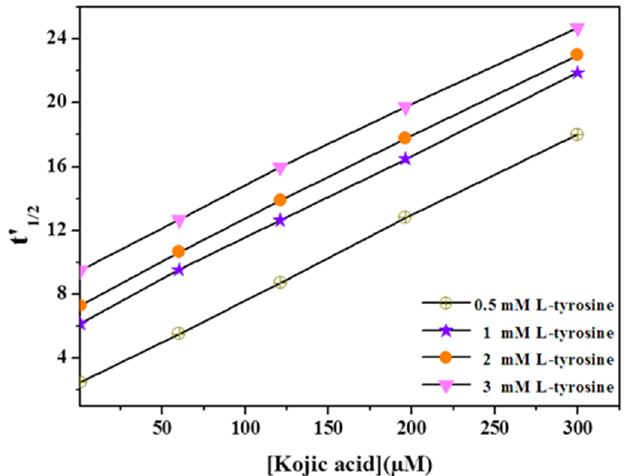
Figure 5. Curve of tyrosinase half-time reaction ( t’ 1/2 ) versus kojic acid concentrations at various concentration of tyrosine 0.5–3 mM. Data are mean ± SD, n = 3.